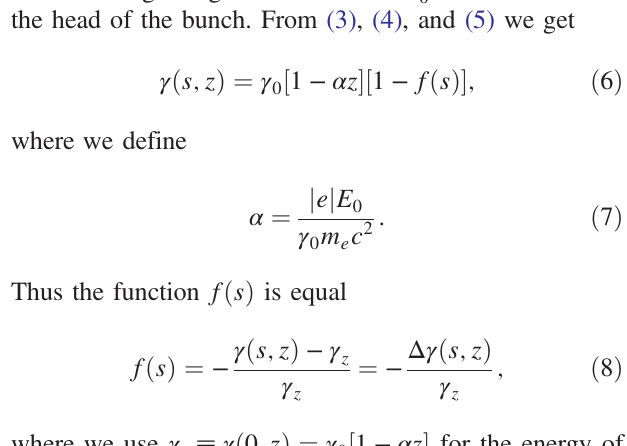
ffiffiffiffiffiffiffiffiffiffiffiffiffi p 1 − α z